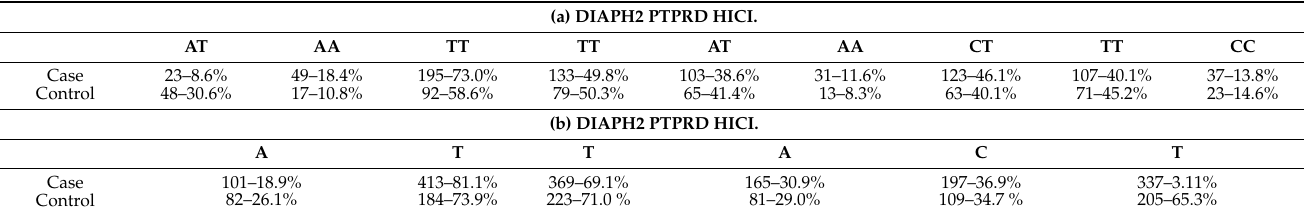
Table 3. Genotypes distribution in laryngeal cancer case group and control group. alleles distribution in laryngeal cancer case group and control group.